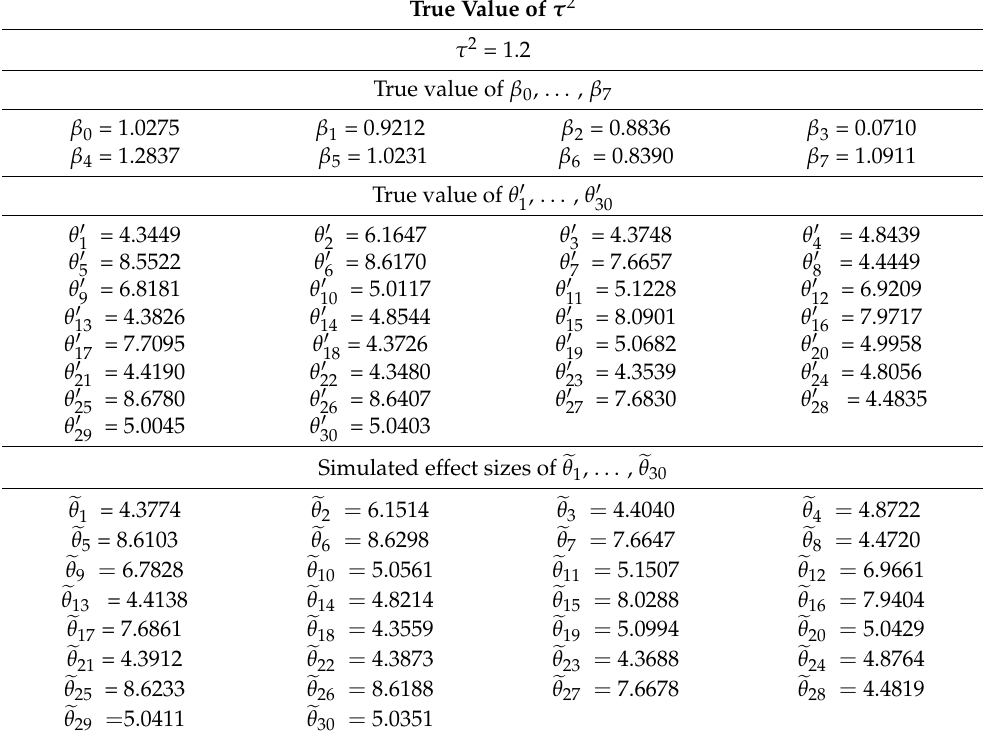
True Value of τ